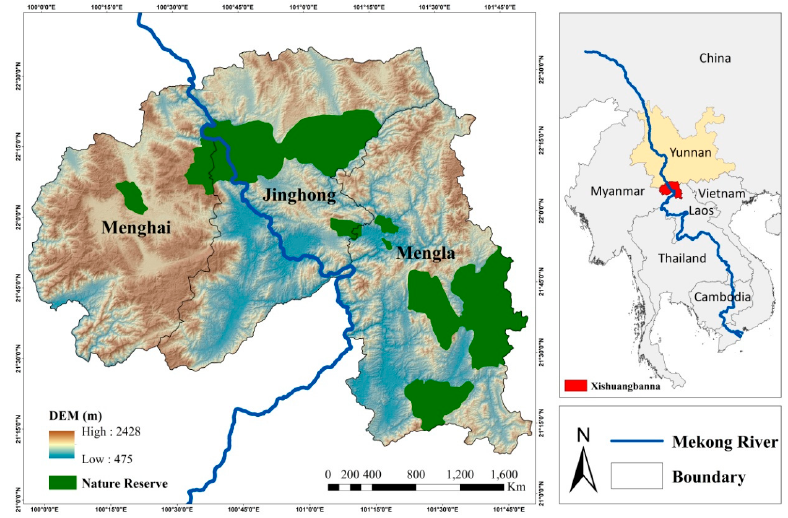
Figure 1. Location of Xishuangbanna.